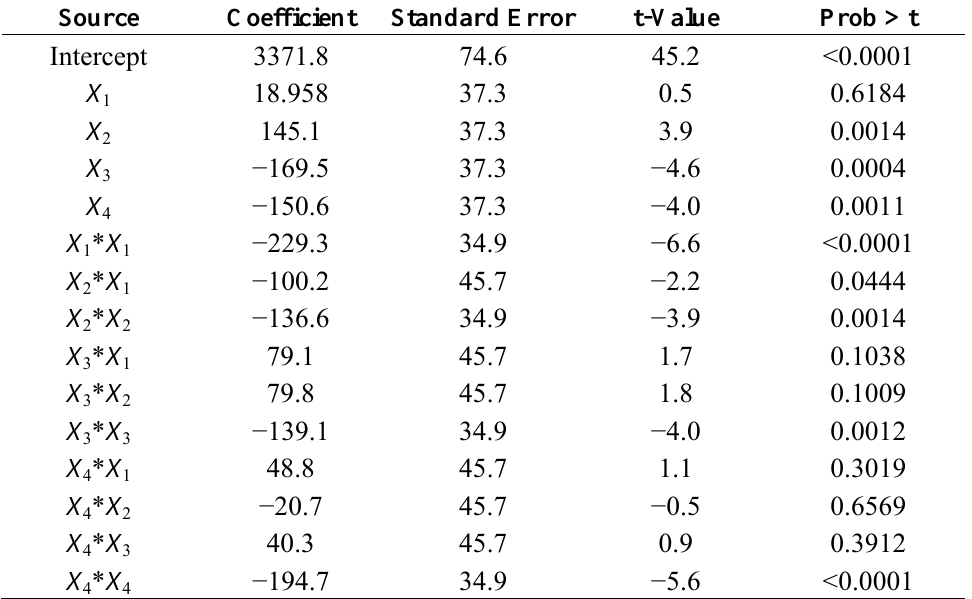
Table 6. Model coefficients estimated by multiple linear regression analysis a .